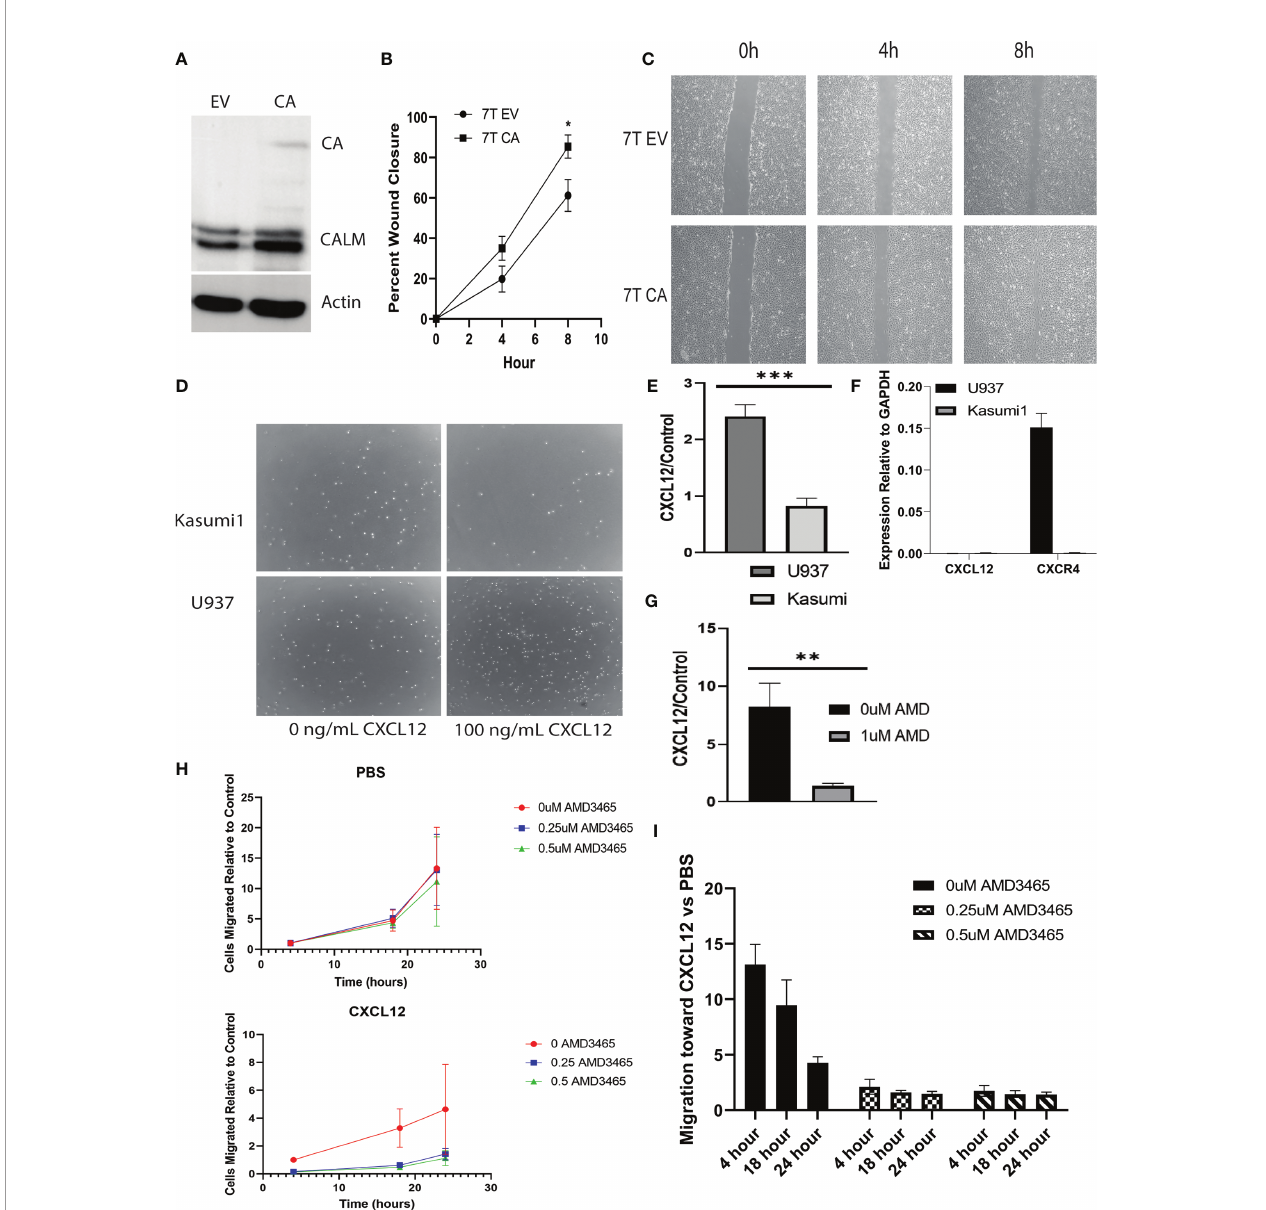
FIGURE 1 | CALM-AF10 leukemia cells show enhanced migration, in fl uenced by CXCL12. (A) A Western blot of MEFs transformed by empty vector (EV) or CALM-AF10 (CA) con fi rms the presence of the CA oncoprotein. (B) Accelerated wound closure in murine embryonic fi broblasts (MEFs) transformed by CALM-AF10 . (C) Representative images from one replicate of scratch assay demonstrate more rapid wound closure in CALM-AF10 transduced MEFs. (D) Representative images from one transwell assay are shown. (E) The impact of CXCL12 as a stimulant for cell migration is examined in U937 and Kasumi cells. (F) qPCR of CXCL12 and CXCR4 in U937 and Kasumi1. (G) The impact of the CXCR4 inhibitor AMD3465 on the migration of U937 cells is evaluated. (H) Dose and time response curves of U937 cells exposed to AMD3465 with and without CXCL12 stimulation reveal migration U937 cells over time (normalized to the 0 AMD3465 condition). (I) Dose and time response experiments in U937 cells using AMD3465 in the present or absence of CXCL12 as a chemoattractant. *p < 0.05; **p < 0.01; ***p <